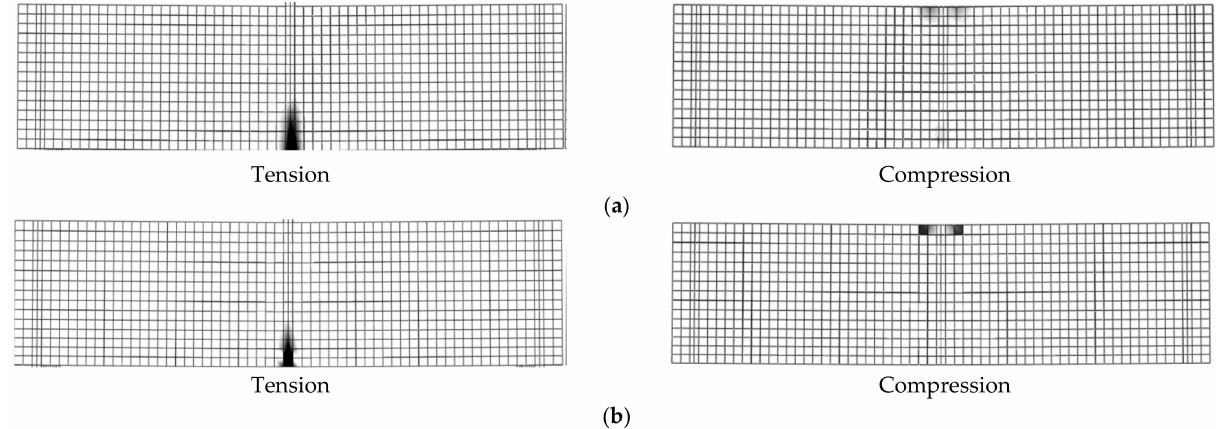
Figure 6. Failure modes of the simulated beams: ( a ) Beam B1; ( b ) Beams B2 and